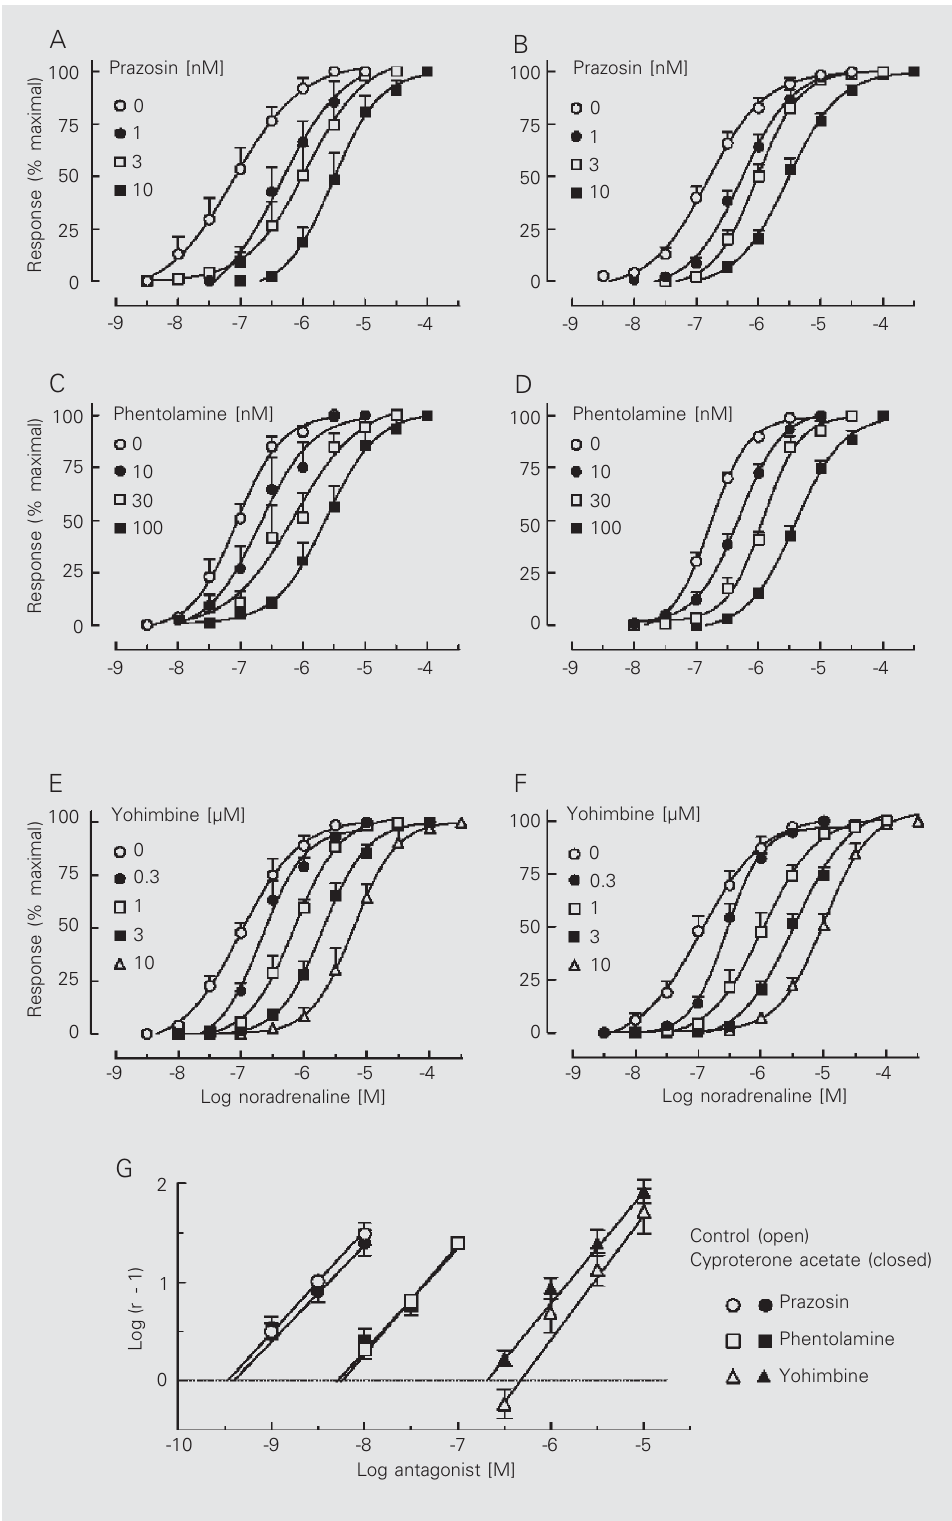
Control (open) Cyproterone acetate